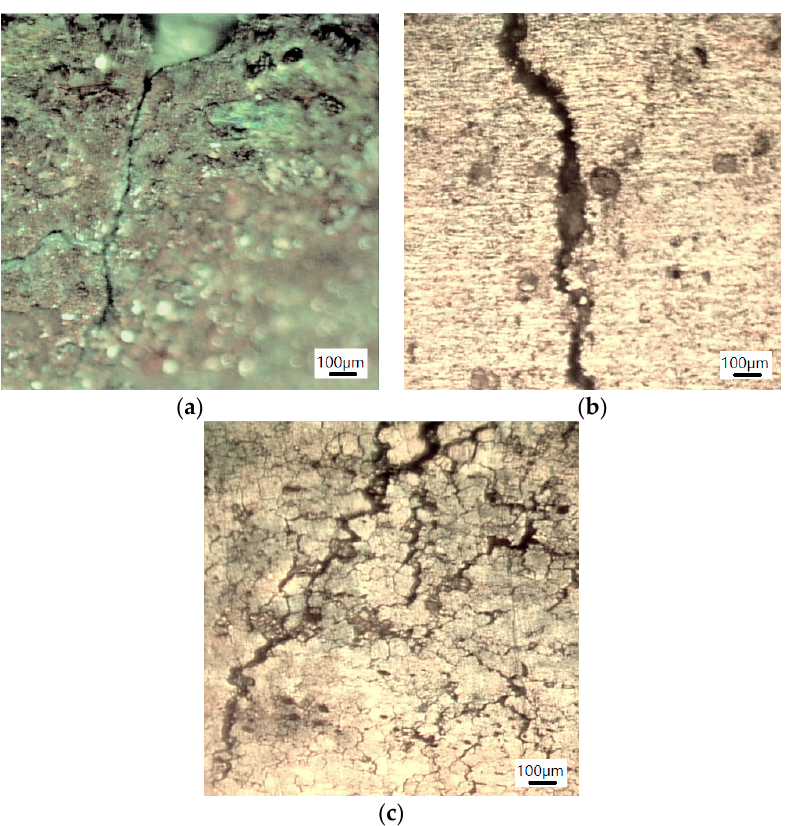
Figure 9. A comparison of the stress-corrosion-related damage of test specimen of the base metal and test specimen containing an FSW joint. (Duration of exposure = 16 h, σ = 118.5 MPa) showing: ( a ) microscopic crack on surface of base metal, i.e., aluminum alloy 2219; ( b ) microscopic crack on surface of test specimen containing the friction stir welded joint; ( c ) microscopic cracks on surface of specimen containing FSW joint.